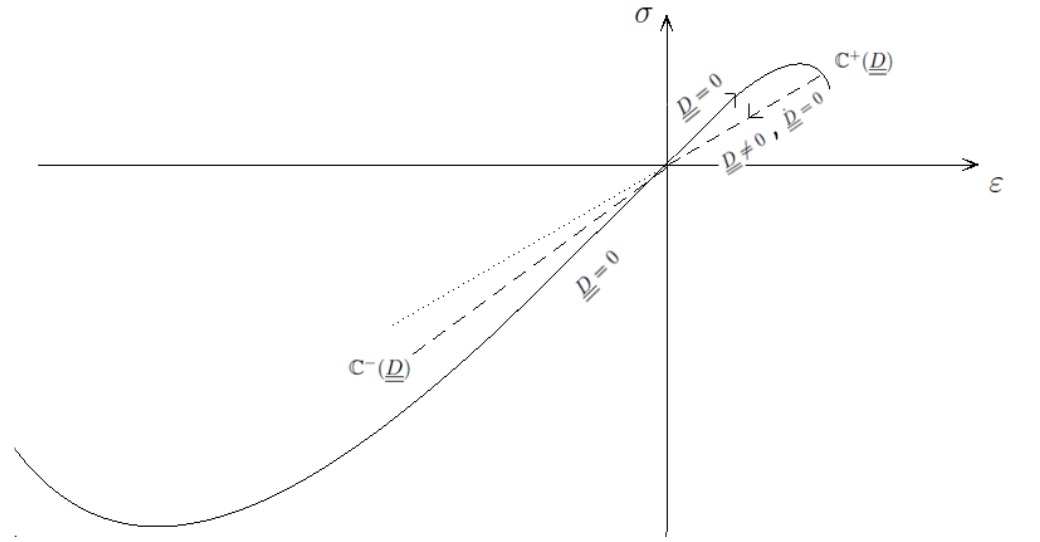
Figure 1. Schematic representation of the transition state between tension and compression